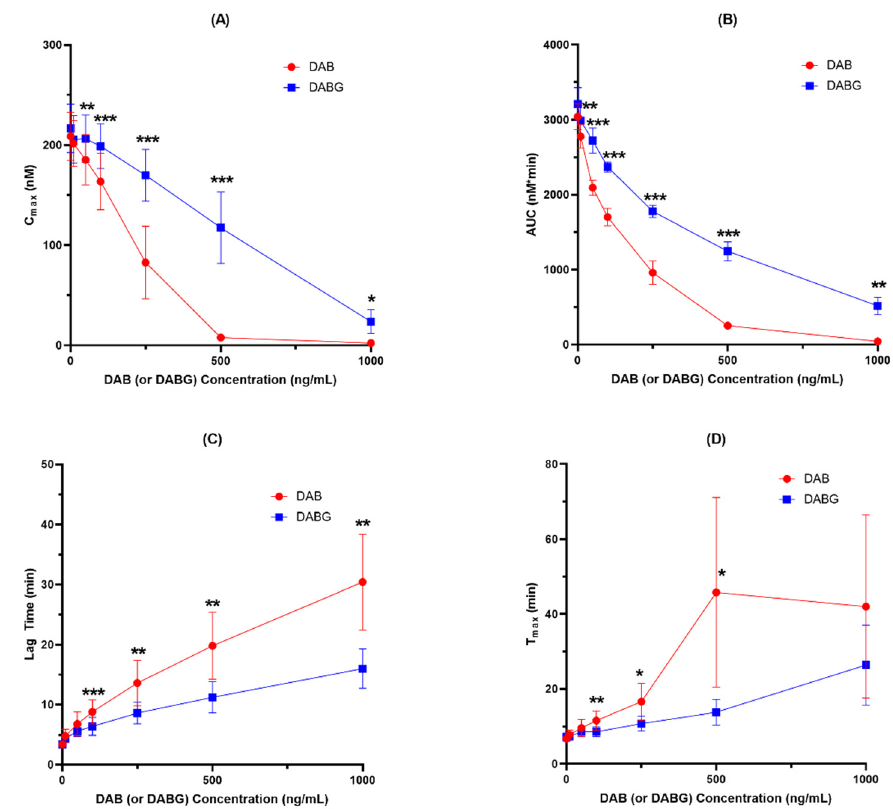
Figure 1. Inhibition of thrombin generation by DAB and DABG ( n = 5). ( A ) C max ; ( B ) AUC; ( C ) Lag time and ( D ) T max . *, p < 0.05; **, p < 0.01; ***, p < 0.001. Both DAB and DABG inhibited thrombin generation in a concentration-dependent manner. In the C max and AUC measurements, DAB inhibited thrombin generation more than DABG. Likewise, lag time and T max showed more prolongation for DAB than for DABG. The kinetics of thrombin generation by DAB and DABG are shown in Figure 2. Comparing the inhibitory potency of DAB and DABG on thrombin generation, the cal- culated IC 50 values of DAB and DABG based on AUCs were 134.1 ng/mL and 281.9 ng/mL, respectively, suggesting that DAB showed 2.10-fold more potent inhibitory effect than DABG. The calculated IC 50 values of DAB and DABG for thrombin generation are shown in Table